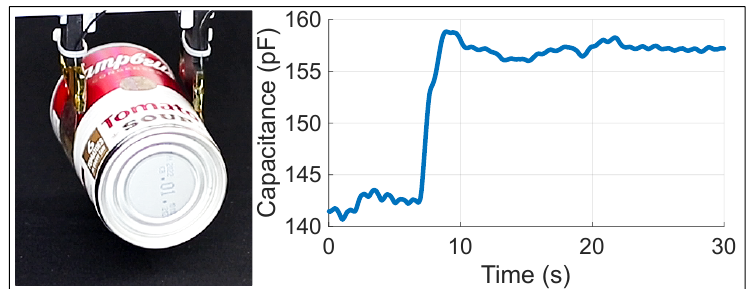
Figure 11. Capacitance variation during the adhesion of the pads onto a curved surface of a metallic can. ( left ) Photo of the pads “clinching” the can; ( right ) plot showing the variation of the capacitance during grasping. The small capacitance dip between 9 and 20 s is given by the pads adjusting to the weight and the inertia of the object when the latter is being manipulated. This is followed by a constant capacitance interval (after 20 s) when the object is being kept hanging